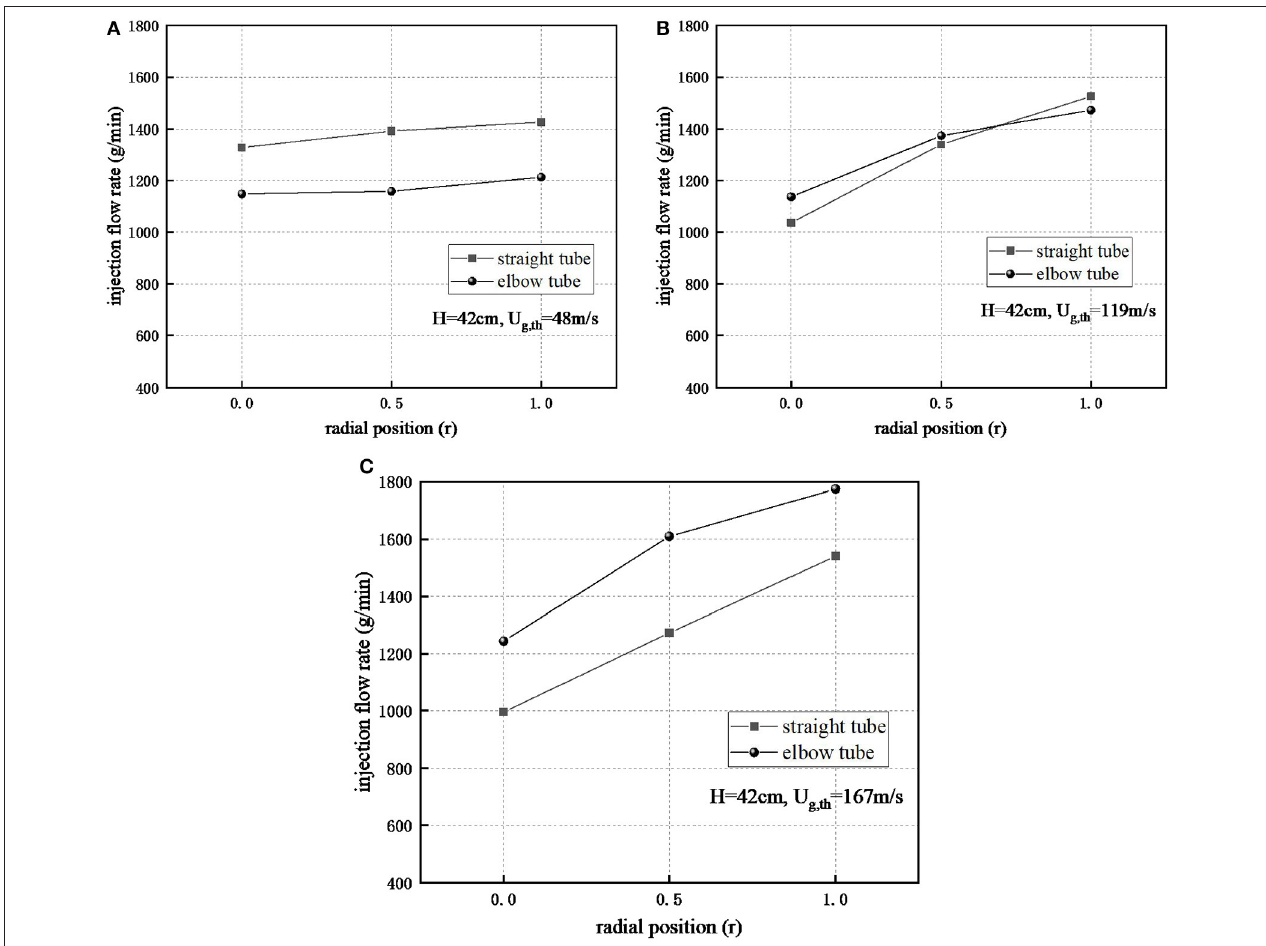
FIGURE 4 | Injection flow rate at submergence depth of 42cm. (A) H = 42cm, U g,th = 48 m/s, (B) H = 42cm, U g,th = 119 m/s, (C) H = 42cm, U g,th = 167